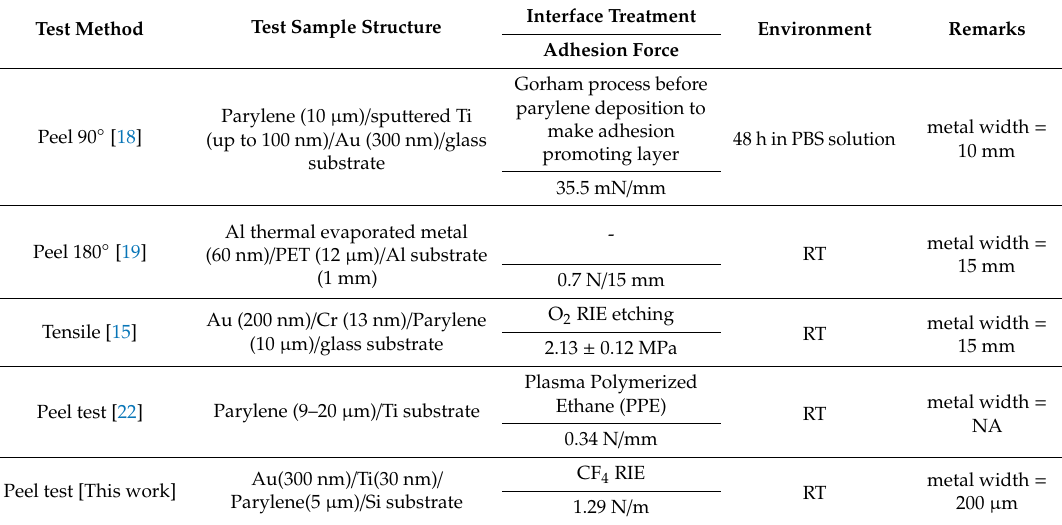
Table 2. Comparison of other research results with scotch tape test.